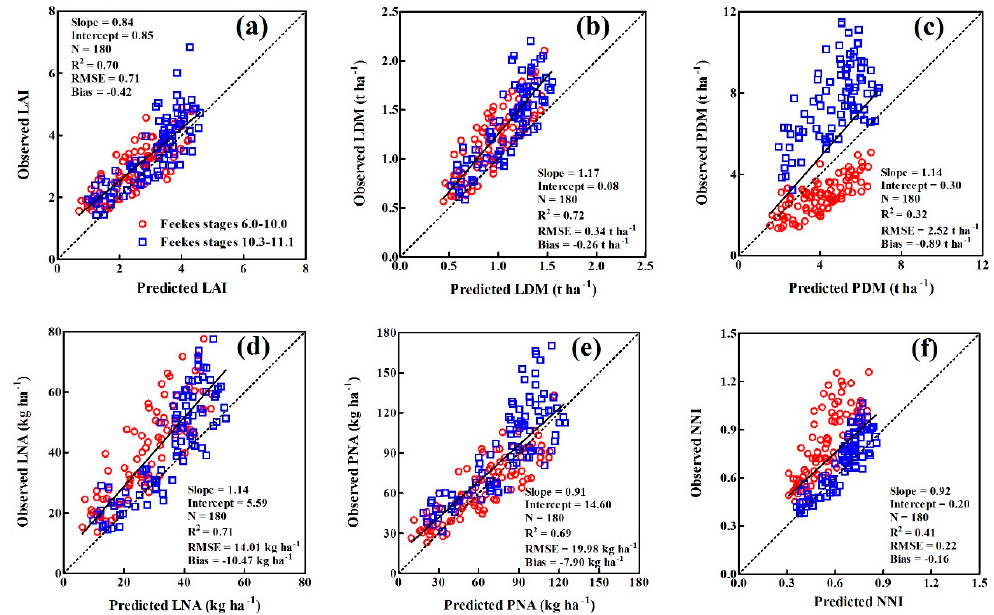
Figure 6. Validation results obtained using the model based on the difference vegetation index (DVI) to predict ( a ) leaf area index (LAI), ( b ) leaf dry matter (LDM), ( c ) plant dry matter (PDM), ( d ) leaf nitrogen accumulation (LNA), and ( e ) plant nitrogen accumulation (PNA) and the model based on the red edge ratio vegetation index (RERVI) to predict ( f ) nitrogen nutrition index (NNI) across all growth stages. Solid black lines indicate regression lines and dotted black lines indicate 1:1 lines.